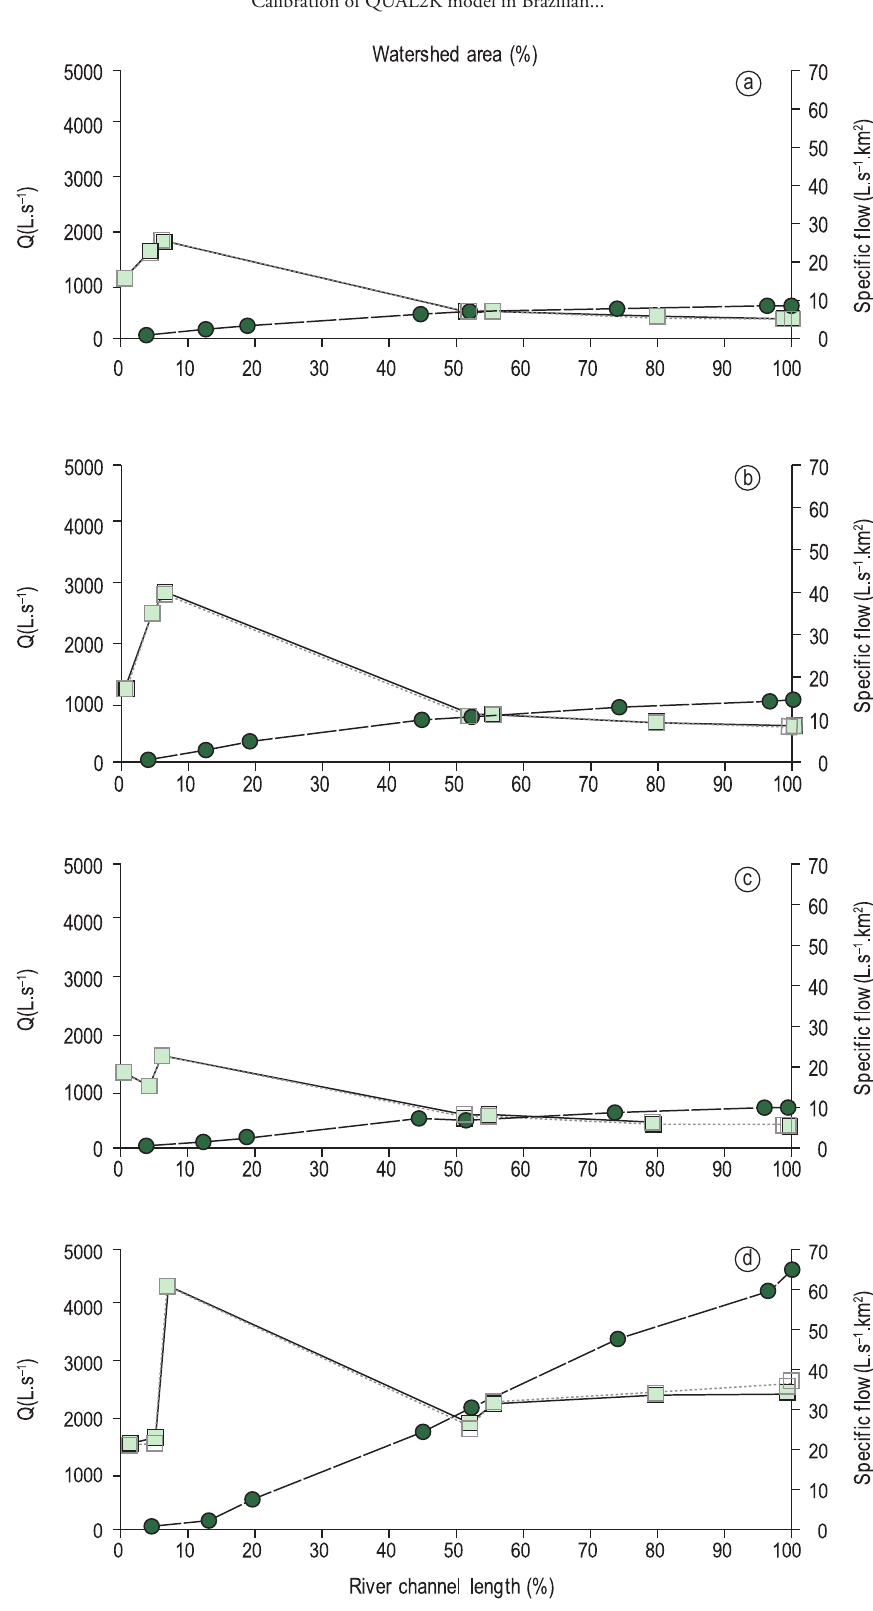
Figure 2. Flow variation in Canha River (inferior abscissa, left ordinate) and specific flow variation in the watershed increment (superior abscissa, right ordinate), during the spring (a - September), summer (b - January), autumn (c - April) and winter (d - July) periods, respectively. ● : observed flow; ■ : observed specific flow; ■ : simulated specific